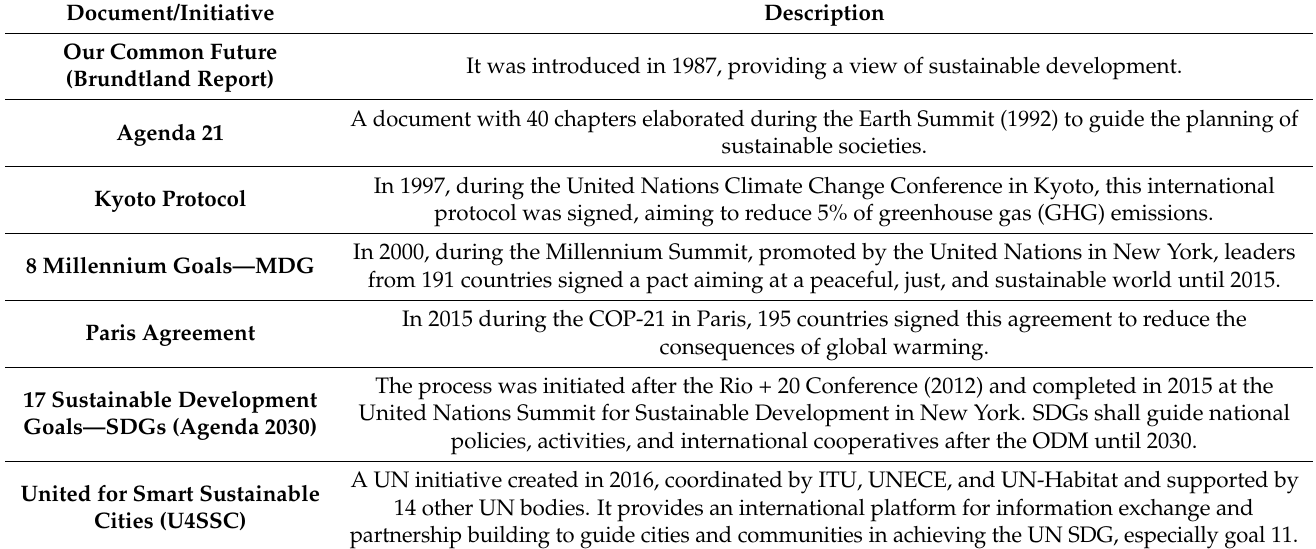
Table 1. Initiatives and documents that make evident the desire for and design of better futures. Elaborated by the author, based on